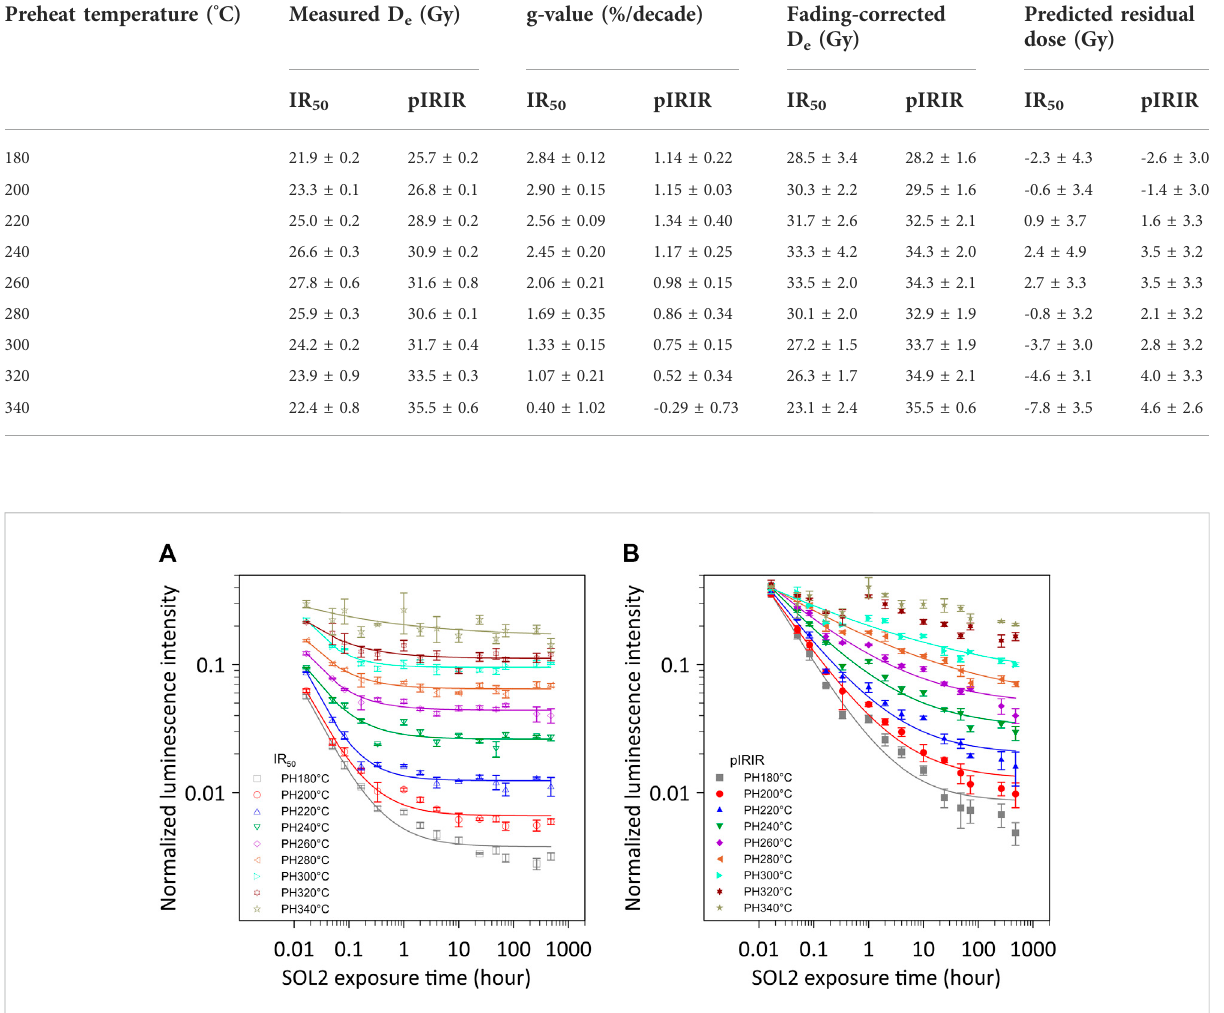
FIGURE 1 Normalized IR 50 (A) and pIRIR (B) luminescence intensity under various preheat (stimulation) temperatures, plotted against SOL2 bleaching time. The pIRIR stimulation temperature is always 30 ° C below the preheat temperature. The bleaching curves were fi tted with the Eq.